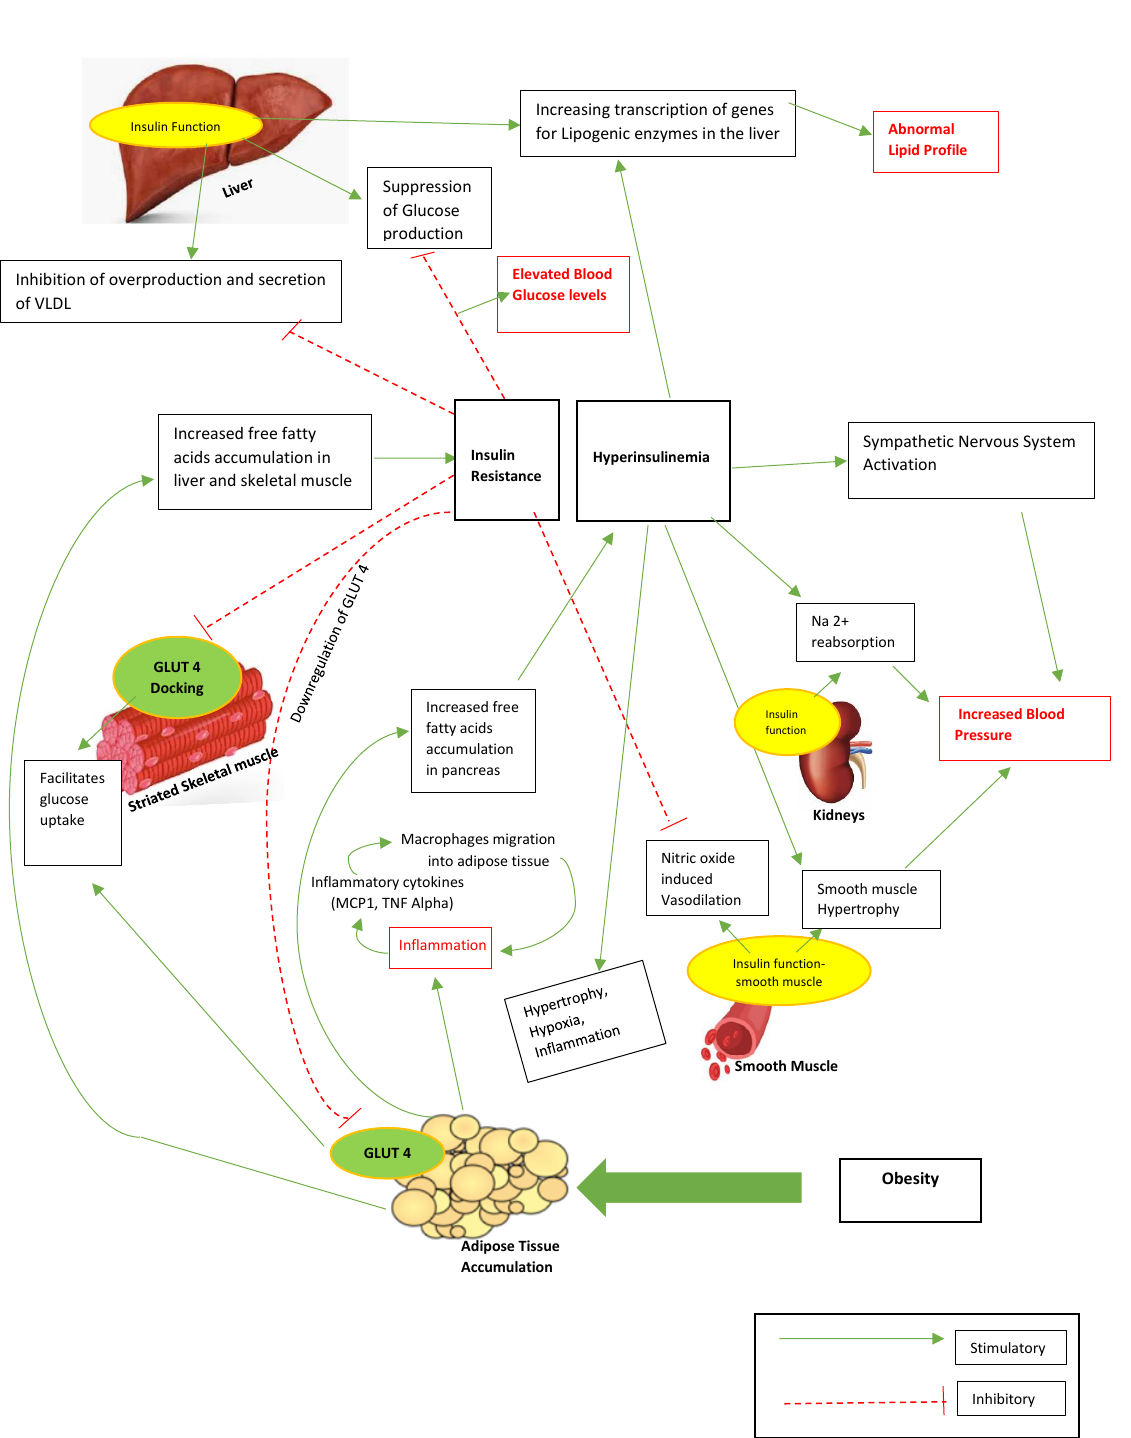
Figure 1. Obesity: insulin resistance model. This is an original illustration by the authors. VLDL: very low-density lipoprotein, GLUT 4: glucose transporter type 4 found on striated muscle and adipose tissue, Na 2+ : sodium, MCP1: monocyte chemoattractant protein 1, TNF Alpha: tumor necrosis factor alpha. The interaction between obesity, insulin resistance, and inflammation leads to metabolic syndrome. Excess free fatty acids deposit in the liver, adipocytes, skeletal muscles, and the pancreas, triggering impairment in insulin signaling and compromising the liver’s suppression of glucose production. Increased insulin levels stimulate lipogenic enzymes in the liver leading to increased production of triglyeride (TG). Insulin resistance and hyperinsulinemia can also lead to elevated blood pressure by causing 1. endothelial dysfunction, 2. insulin-induced sympathetic excitation, which leads to vasoconstriction and arterial hypertension, 3. sodium retention in kidneys, and 4. smooth muscle hypertrophy